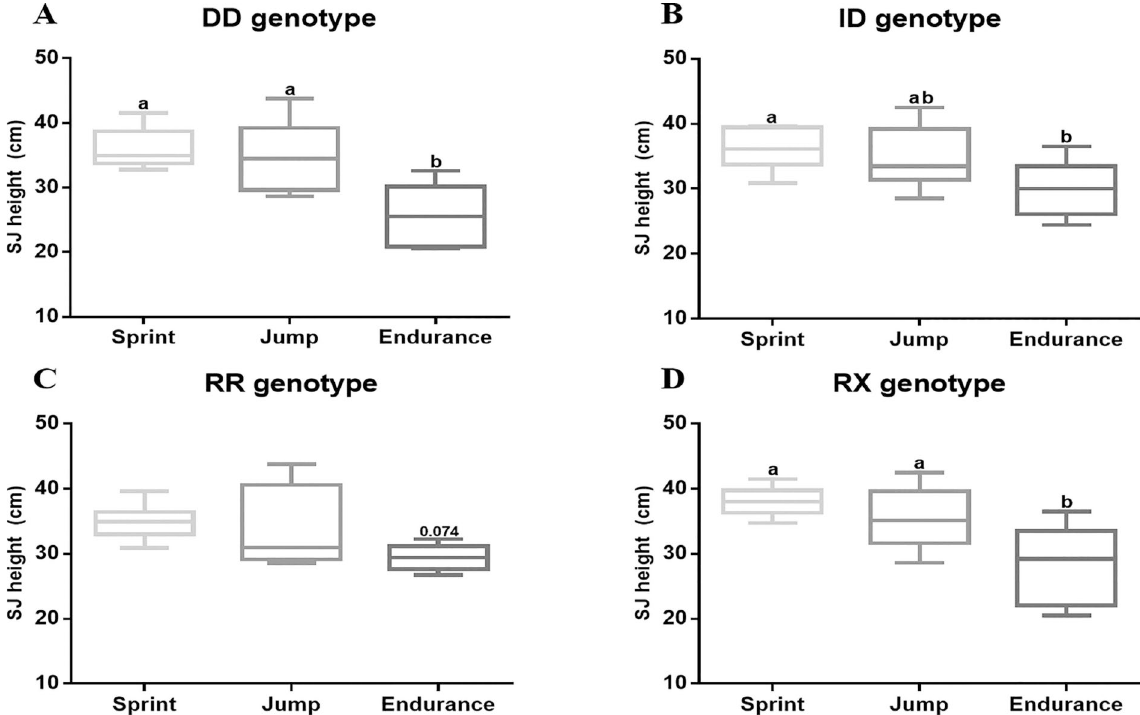
Figure 2 - Effect of ACE and ACTN3 gene variants on SJ in young talents. The DD genotype (a), ID genotype (b), RR genotype (c) and RX genotype (d). Different letters indicate significant differences between groups (one-way test (ANOVA) followed by Tukey's test, p <